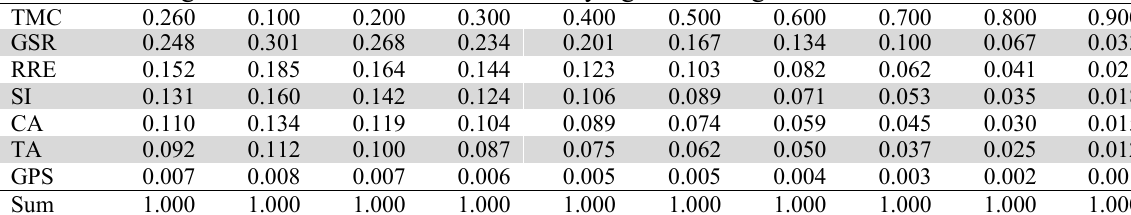
Variation in weights value for all enablers when varying TMC weight value TMC 0.260